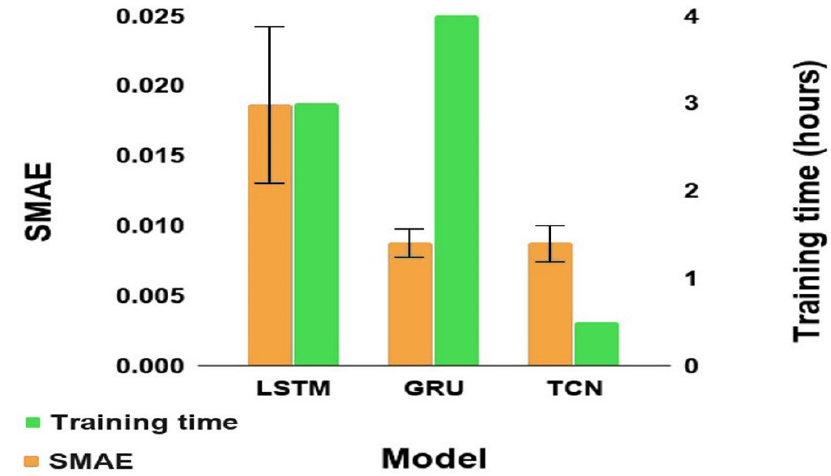
Figure 11. Training times and testing scaled mean absolute error (SMAE).